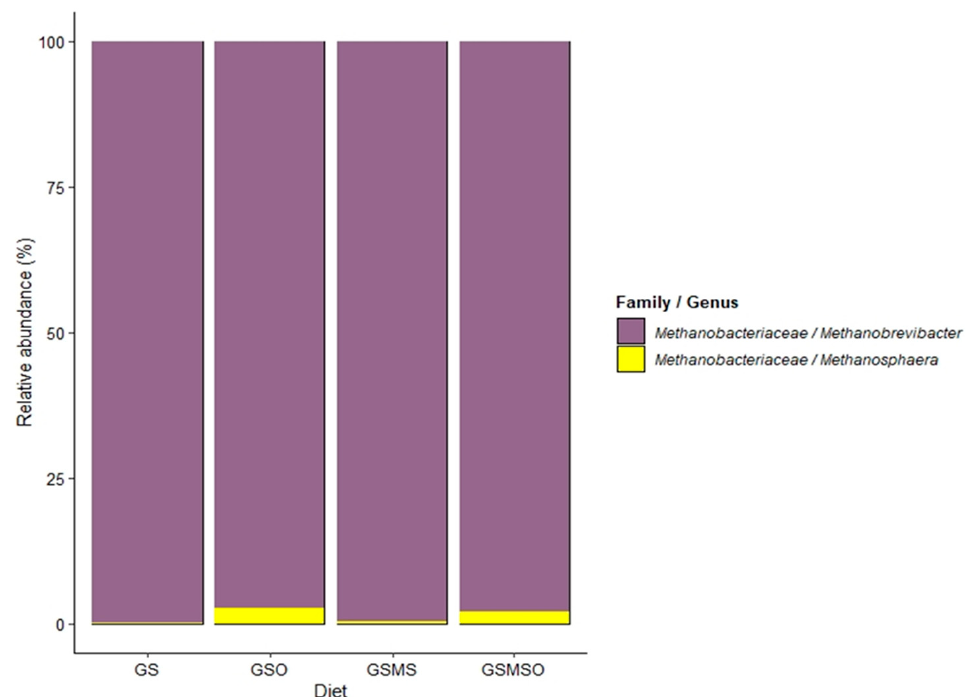
Figure 2. Archaea family and genus composition in rumen fluid, shown as mean percentage relative